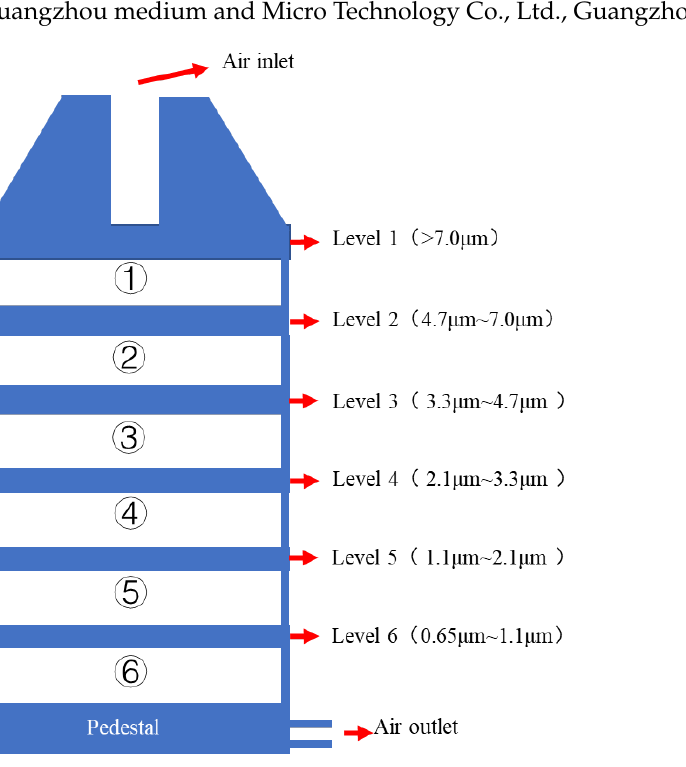
Figure 1. Structure diagram of bacterial sampler. ① – ⑥ are the places where agar plates are placed, and levels 1 – 6 can selectively collect aerosols with corresponding particle size.